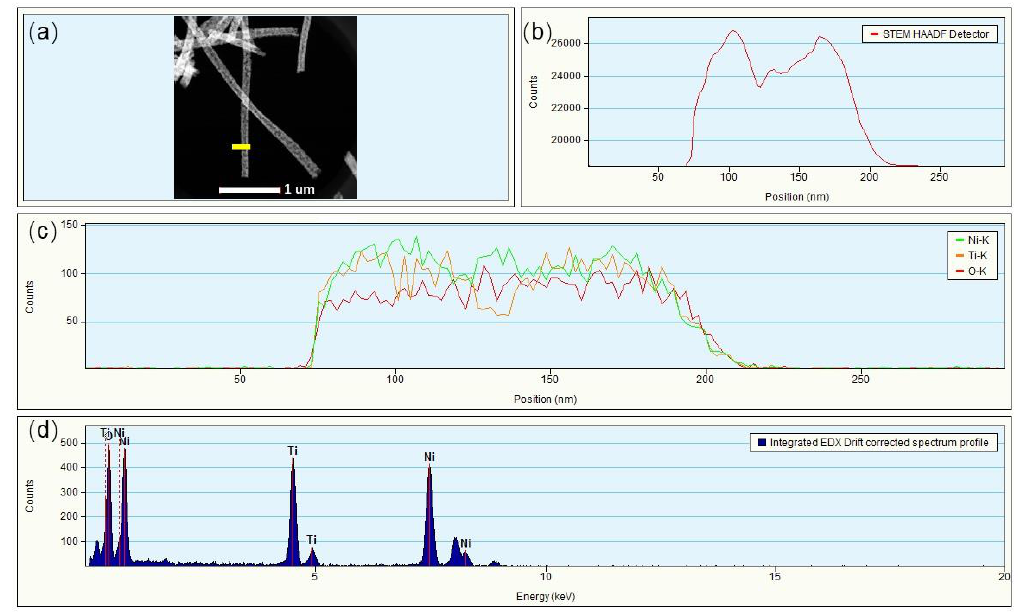
Figure 6. ( a ) STEM-HAADF images of NiO(10%) / NiTiO 3 composite nanofiber films, ( b , c ) show the EDX element Line Scanning of the yellow line in (a), ( d ) shows the EDX energy spectrum.